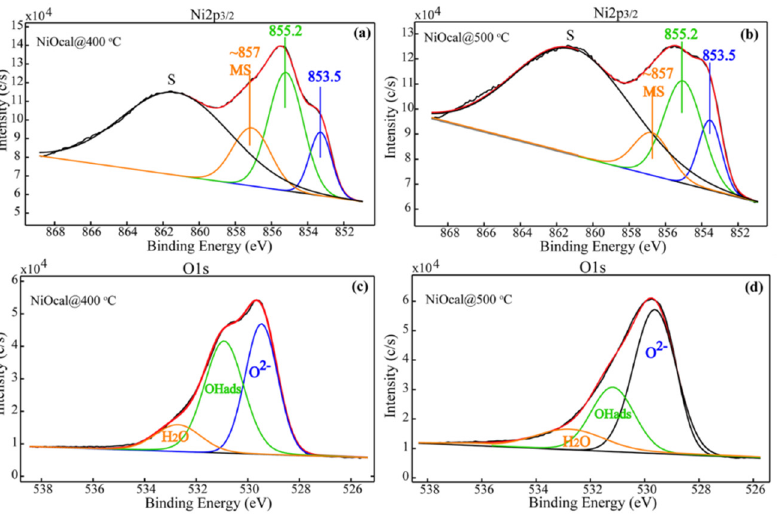
Figure 5. Deconvoluted Ni2p 3/2 ( a , b ) and O1s high resolution spectra ( c , d ) for NiO cal@400 ◦ C and NiO cal@500 ◦